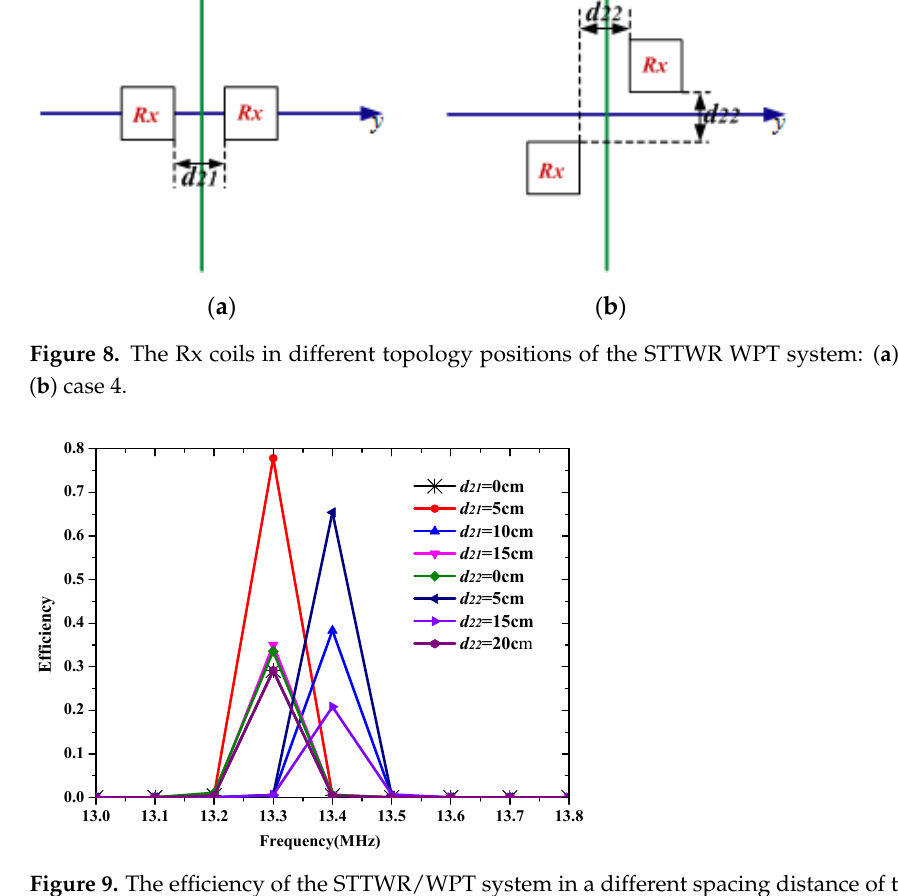
Figure 9. The efficiency of the STTWR/WPT system in a different spacing distance of the adjacent Rx coils.